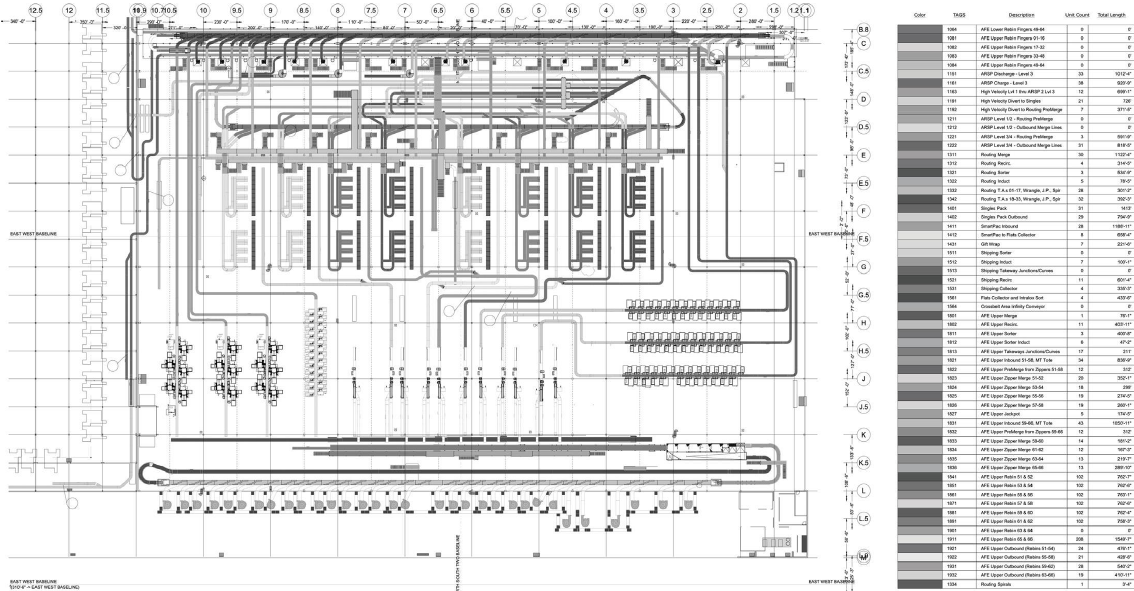
Figure 1: Material fow from upstream order picking processes to downstream order packing and shipping on a fulfllment sorter (source: dematic sorters